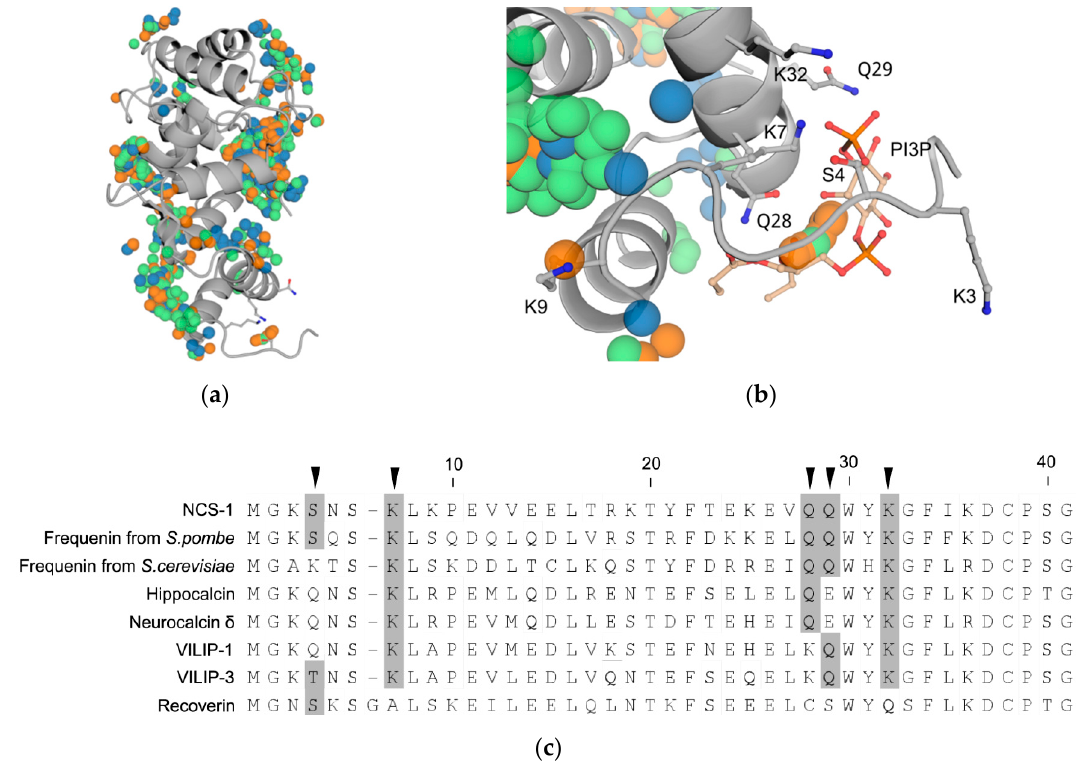
Figure 6. Molecular docking of phosphatidylinositol-monophosphates into unmyristoylated NCS-1 (PDB: 2LCP; frame 10). ( a ) Centers of mass of PI3P (orange spheres), PI4P (green spheres) and PI5P (blue spheres) docked into NCS-1. ( b ) Putative PI3P-binding site. NCS-1 residues making electrostatic contacts or hydrogen bonds with PI3P as well as conserved lysine residues K3 and K9 are shown as sticks. ( c ) Sequence alignment of human NCS-1, its yeast homologs frequenins, and closely related members of the NCS family. Residues of the putative PI3P-binding site are marked with black arrowheads, conserved residues in these positions are highlighted in gray.